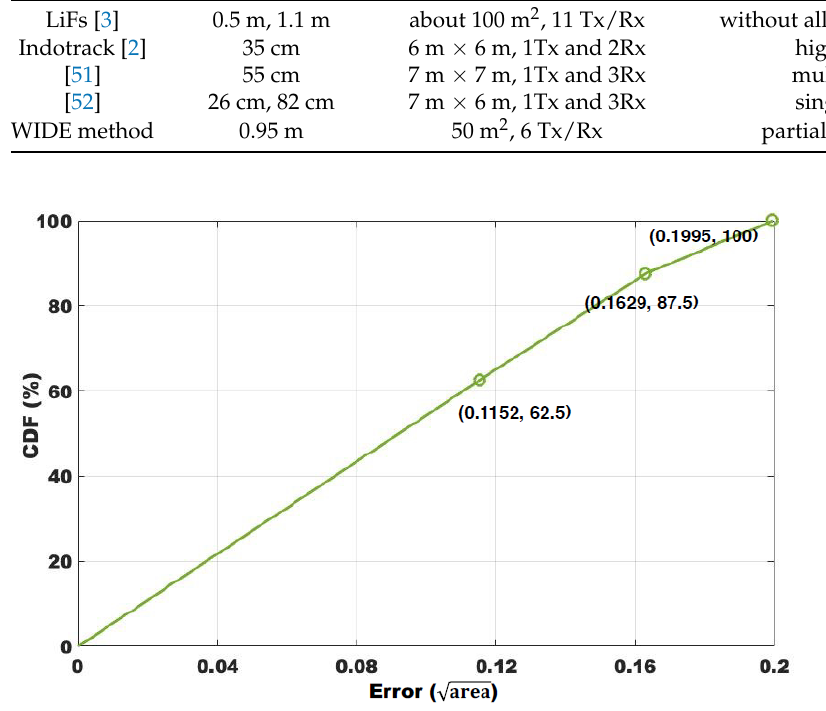
Figure 14. CDF of the error in a a ∗ b room with 3 × 3 transceivers. As the total area increases, the growth rate of the tracking error is slowed down, and the change is very small, as shown in Figure 15.